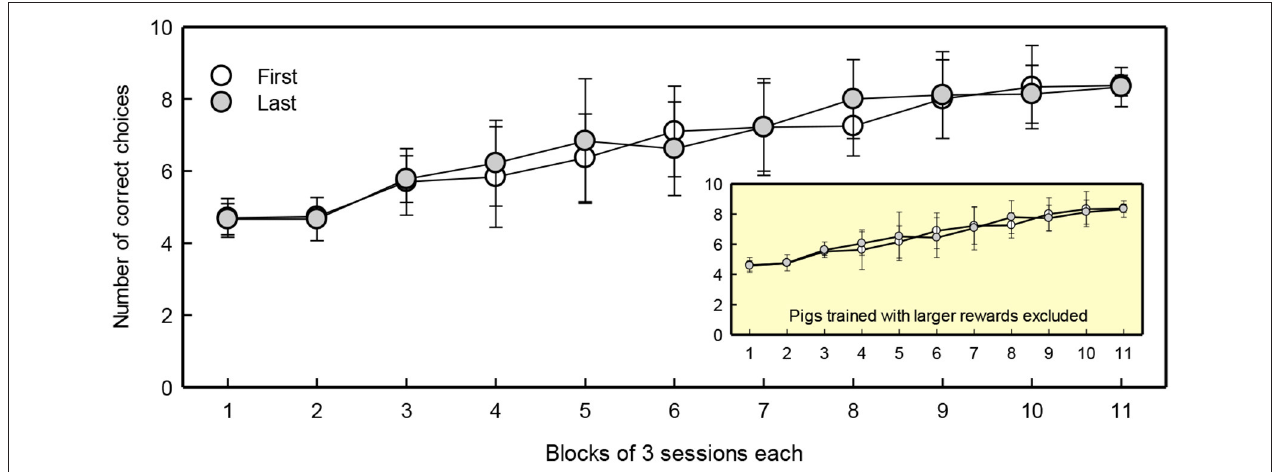
FIGURE 4 | Number of correct choices per block of three sessions of first and last-born pigs. The learning curve with exclusion of pigs trained with a larger reward is provided in the right lower corner as insert. The means ± SEMs are depicted.